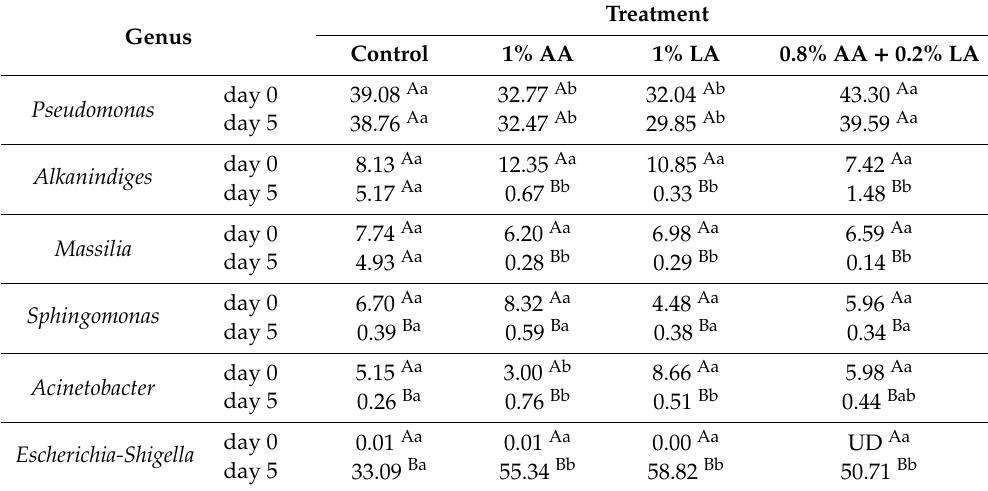
Table 3. Mean relative abundance (%) of bacteria at the genus